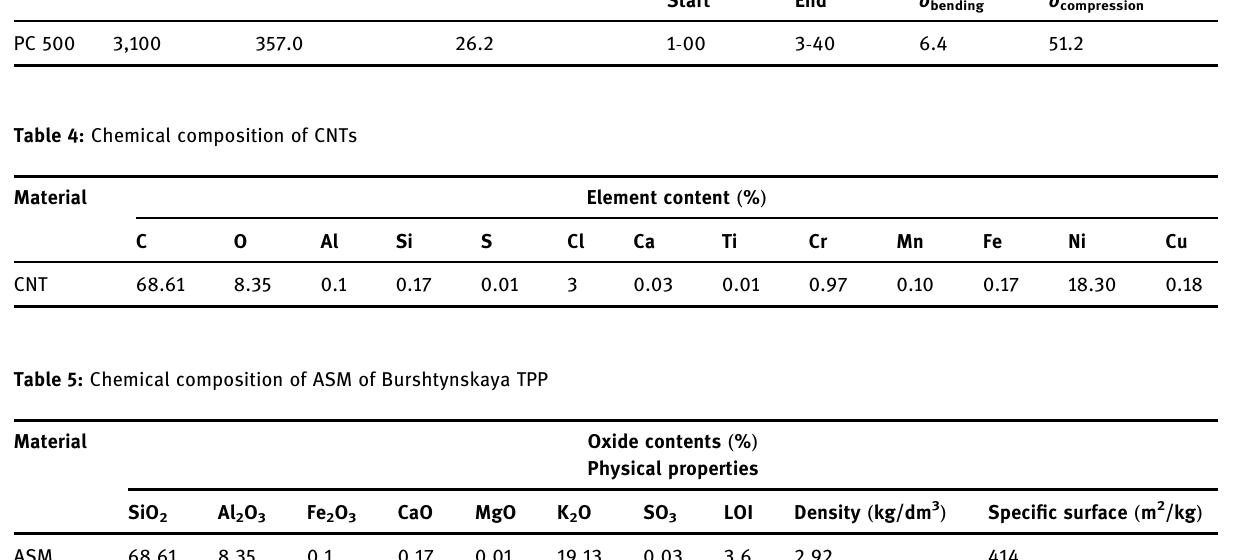
Table 3: Physical and mechanical properties of PC PC brand Density ( kg/m 3 )